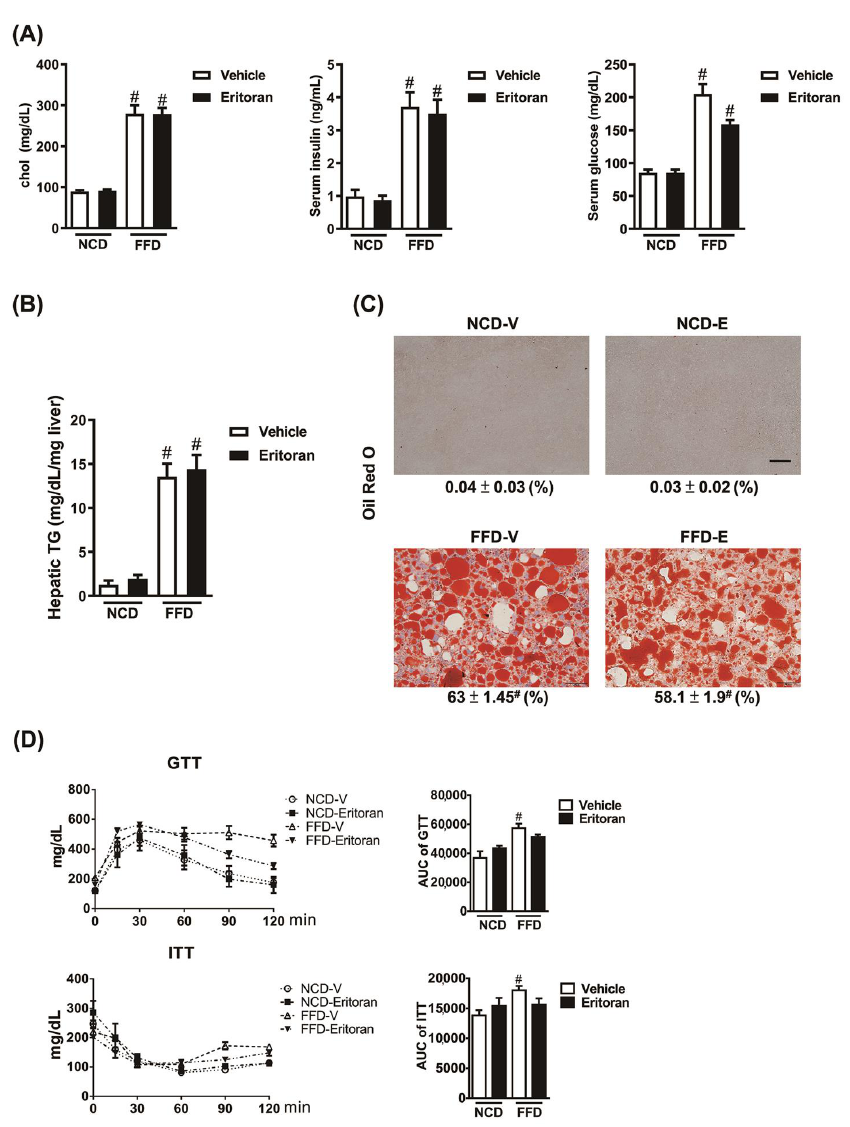
Figure 4. Eritoran did not reduce hepatic steatosis or systemic insulin resistance in the FFD-fed mice. ( A ) Serum cholesterol (chol), insulin and glucose levels. ( B ) Hepatic triglyceride (TG) levels. ( C ) Oil Red O staining of the liver sections and quantification of the stained areas (%). Scale bar = 50 µ m. Tissue sections from all the mice were stained and quantified (means ± SEM). ( D ) Glucose tolerance testing (GTT) and insulin tolerance testing (ITT) of the groups. AUC: area under the curve. NCD- V/NCD-E: the mice fed a normal chow diet (NCD) were injected with a vehicle (NCD-V, n = 6) or eritoran (NCD-E, n = 6); FFD-V/FFD-E: the mice fed a fast-food diet (FFD) were injected with a vehicle (FFD-V, n = 10) or eritoran (FFD-E, n = 9); # p < 0.05 vs.